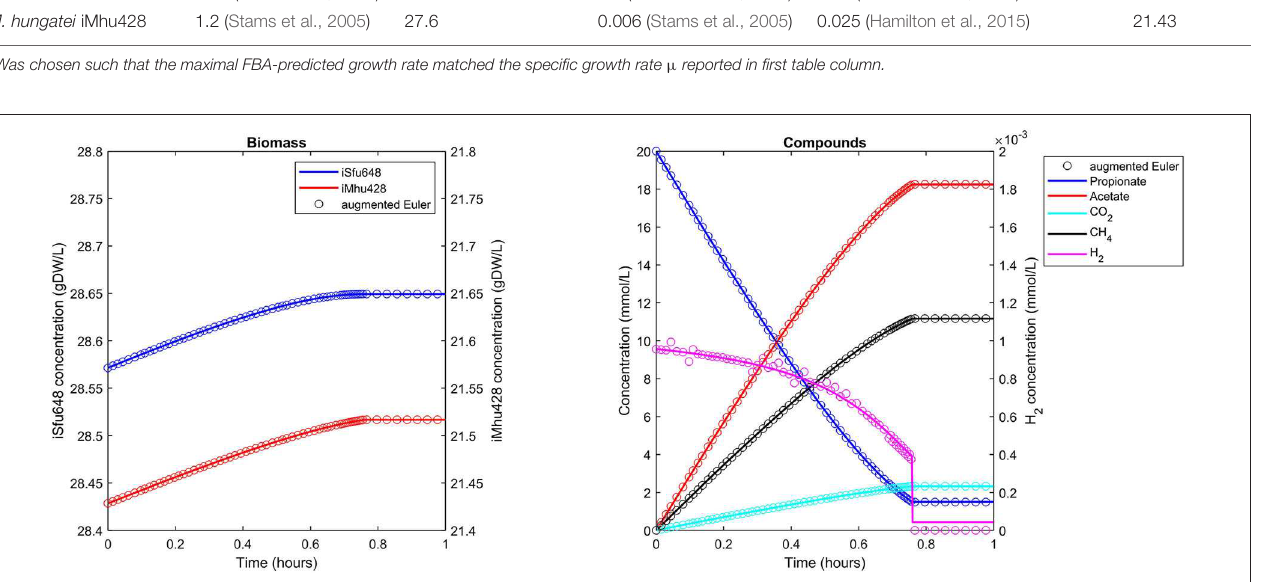
FIGURE 3 | Simulating a syntrophic batch co-culture. Propionate is utilized by S. fumaroxidans and converted to acetate, CO 2 , and H 2 . M. hungatei then converts CO 2 and H 2 to CH 4 . Both Matlab’s ode15s ODE solver (lines) and µ bialSim’s augmented forward Euler method (symbols, every 15th data point is plotted) lead to similar results. As H 2 is faster consumed than produced, the time step size gets frequently reduced, most notably just prior to the depletion of propionate after which growth of both populations